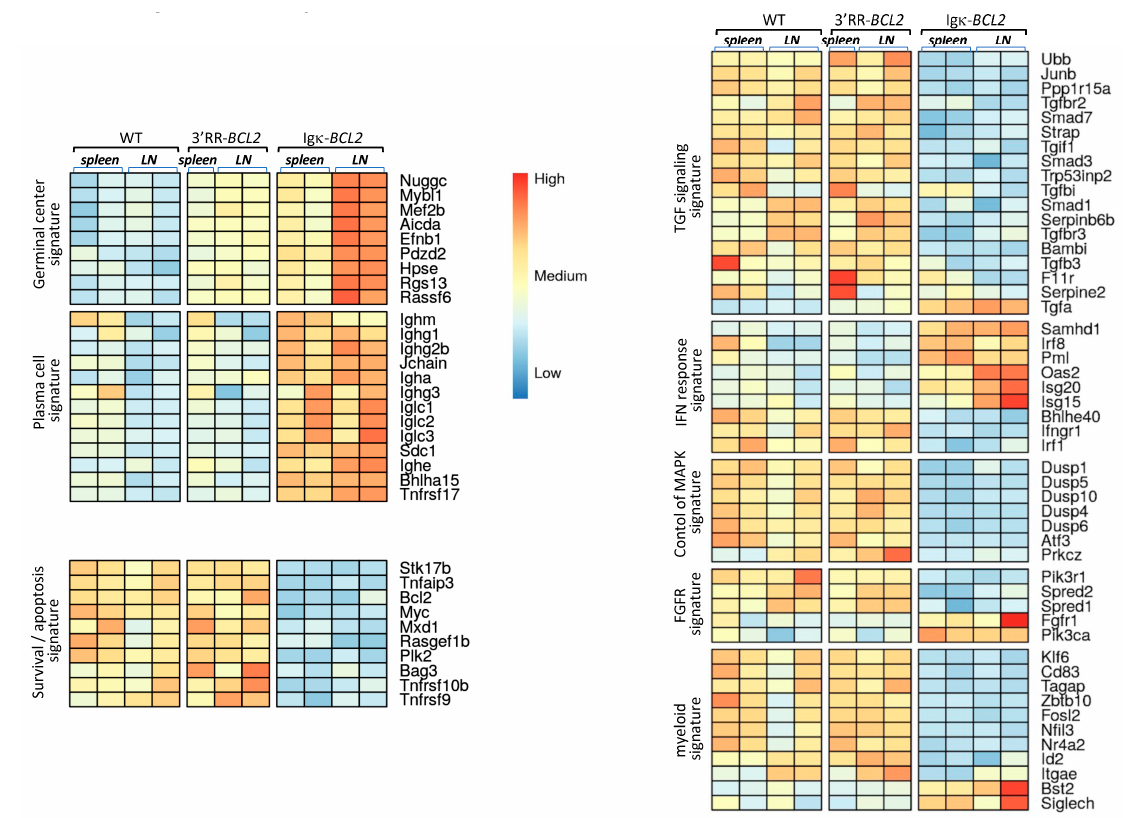
Figure 4. Transcriptomic signatures in whole lymphoid tissues from SRBC-immunized animals. Main transcriptional signatures, combining genes with significant variations, comparing WT to 3 ′ RR-BCL2 and Ig κ -BCL2 RNAseq profiles from lymphoid tissues (spleen and mesenteric lymph nodes) taken from SRBC-immunized mice.